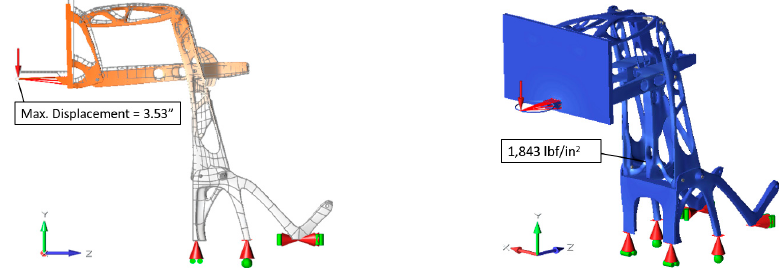
Figure 6. 7 ft. Configuration displacement ( left ) and stress ( right ) contour results.